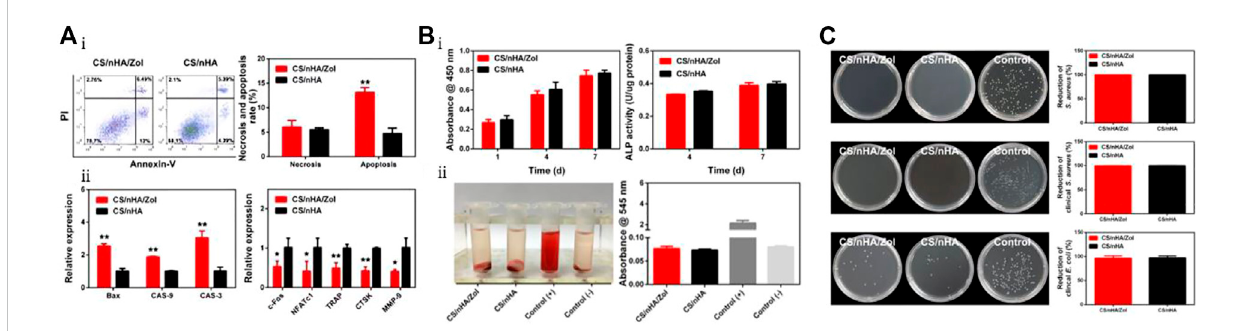
FIGURE 3 (A) Apoptosis and gene expression after co-culturing GCTBs with CS/nHAp/Zol. (Ai) Analysis of apoptosis and necrosis in GCTBs cells co-cultured with CS/nHAp for 2 days using fl ow cytometry. Percentage of necrotic and apoptotic cells in GCTBs. CS/nHAp/Zol upregulated the apoptotic rate of the cells. (Aii) Relative expression of apoptotic and osteoclast-related genes in GCTBs after co-culturing with CS/nHAp/Zol for 2 days. (B) Biocompatibility andosteogenicdifferentiation-promotingabilityofCS/nHAp/Zol. (Bi) CellproliferationactivityofhBMSCsco-culturedwiththescaffoldfor1,4,and 7 days as detected byCCK-8, and theeffect of co-culturing with the scaffold for 4 and 7 days on hBMSCs ALP activity. (Bii) Hemolysis test of the scaffold materials,andbothgroupsofscaffoldsdidnotcausehemolysis. (C) Antibacterial